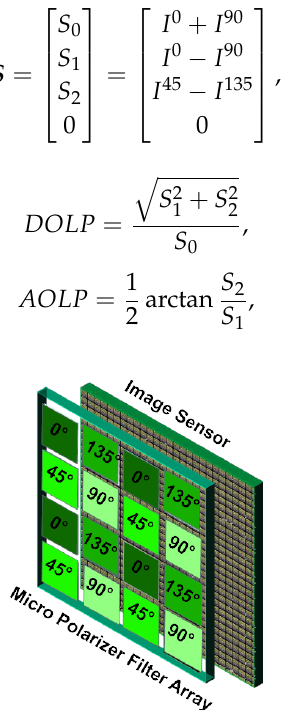
Figure 1. Polarization Filter Array principle. A polarization filter array covers the pixel matrix of a radiometric sensor. The array of polarimetric filters are located, either directly above the matrix of pixels, or over the micro-lens